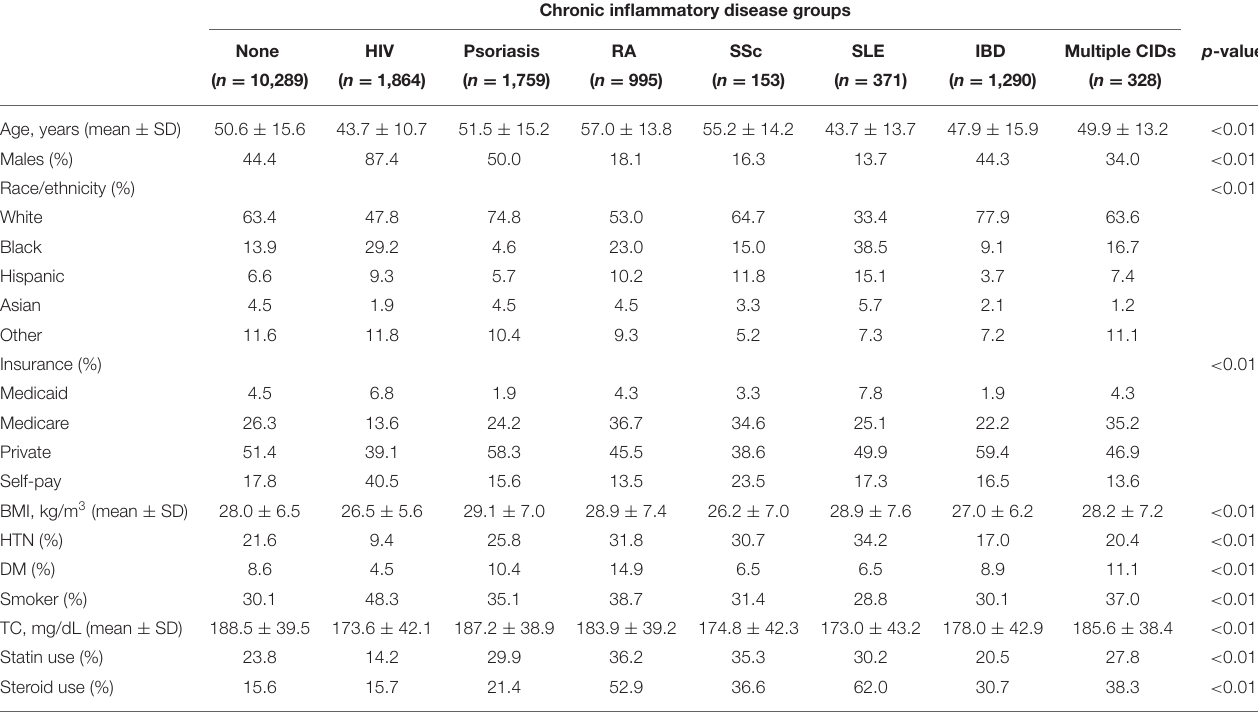
TABLE 1 | Baseline clinical characteristics of controls and chronic inflammatory disease groups in the nested cohort. Chronic inflammatory disease groups None HIV Psoriasis RA SSc SLE IBD Multiple CIDs p -value